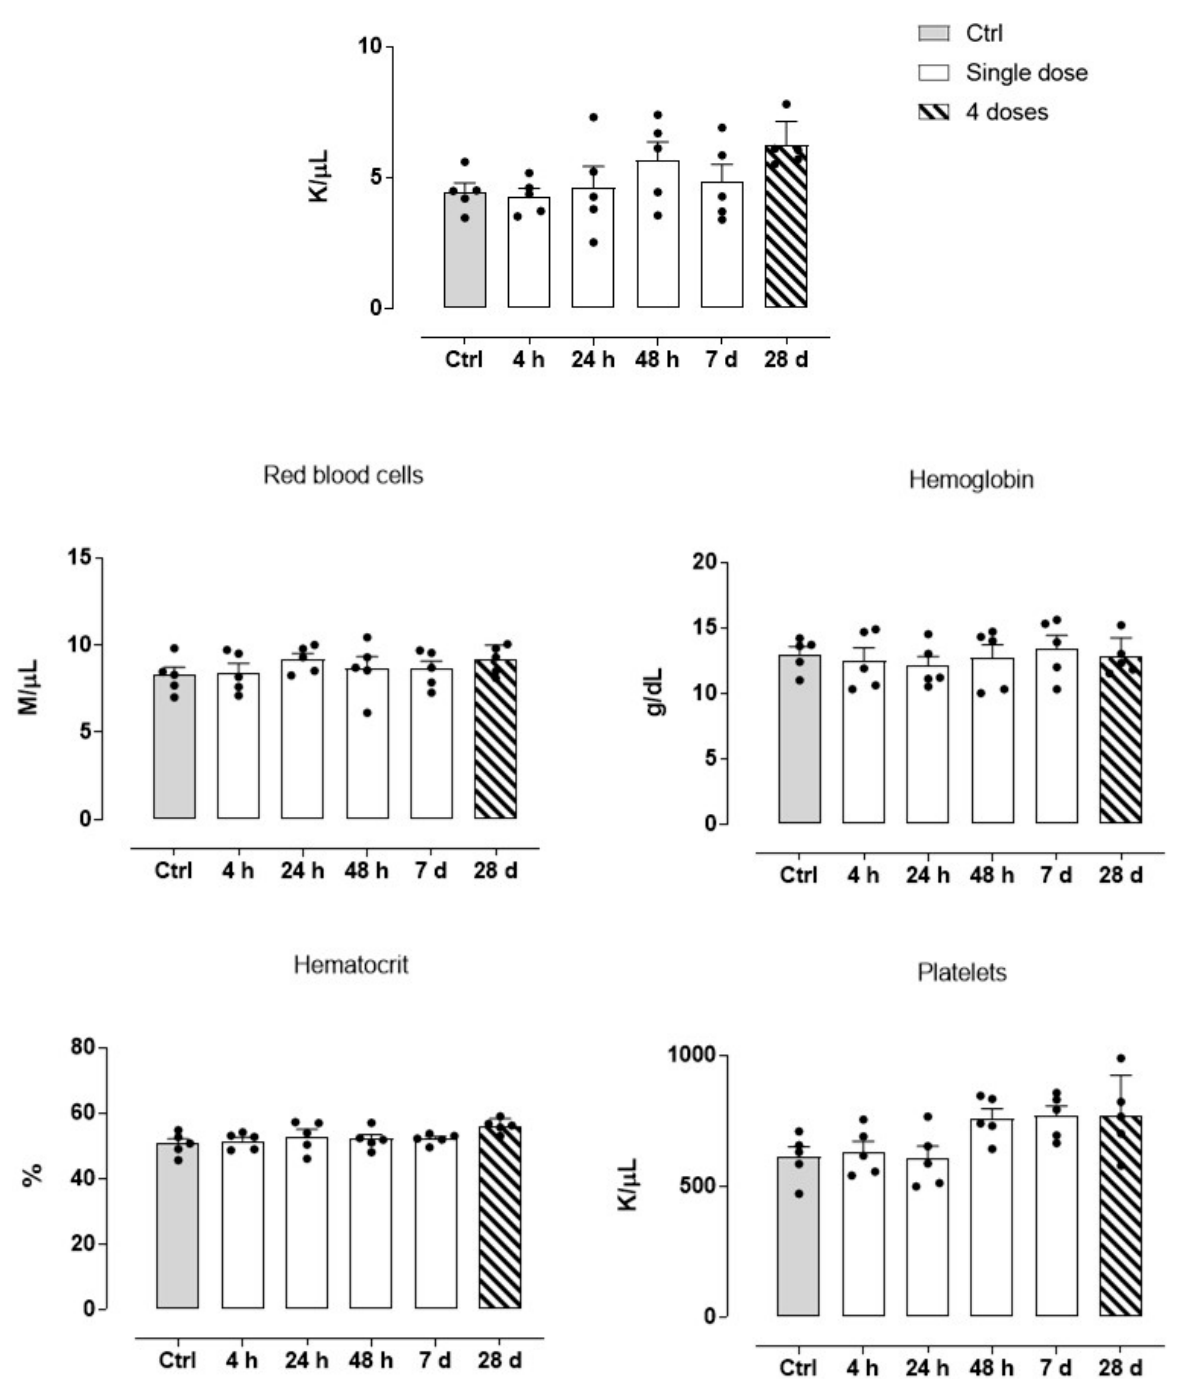
Figure 7. Complete blood count (CBC) test on blood samples taken 4, 24, and 48 h, and 7 days (white bars, “Single dose”) after a single HoThyRu/DOTAP dose (15 mg/kg, i.p. ), and after weekly administrations (ribbed bars, “4 doses”) of HoThyRu/DOTAP (15 mg/kg, i.p. , once a week for 4 weeks), showing the red and white blood cells count, haemoglobin, haematocrit, and total platelets ( n = 5 animals per time point). Values from control group (non-xenotransplanted mice) were used as reference values and are plotted in graphs as grey bars. Statistical analysis was conducted by one-way ANOVA followed by Bonferroni’s for multiple comparisons.